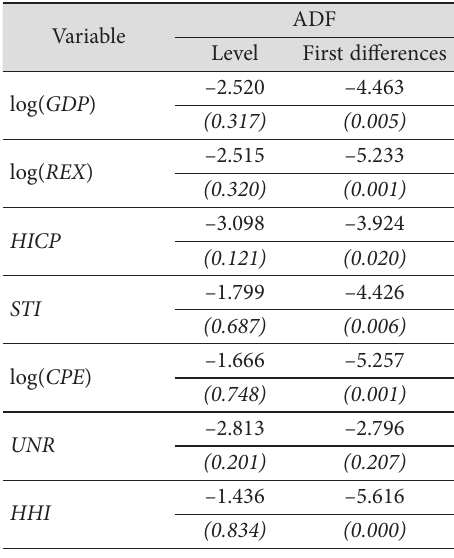
Table 8. Unit root test (macroeconomic